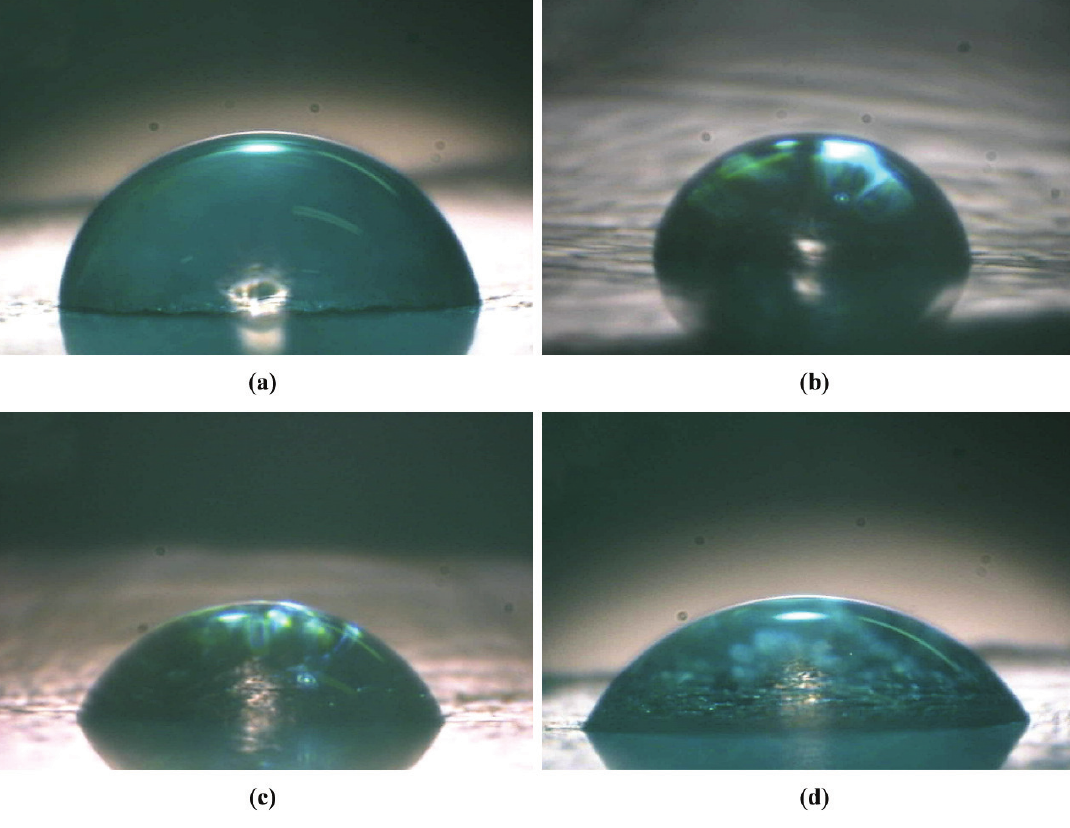
Figure 5. Images obtained for the contact angle determination by the sessile drop method: (a) tin plate, (b) acetic, (c) hydrochloric and (d) nitric